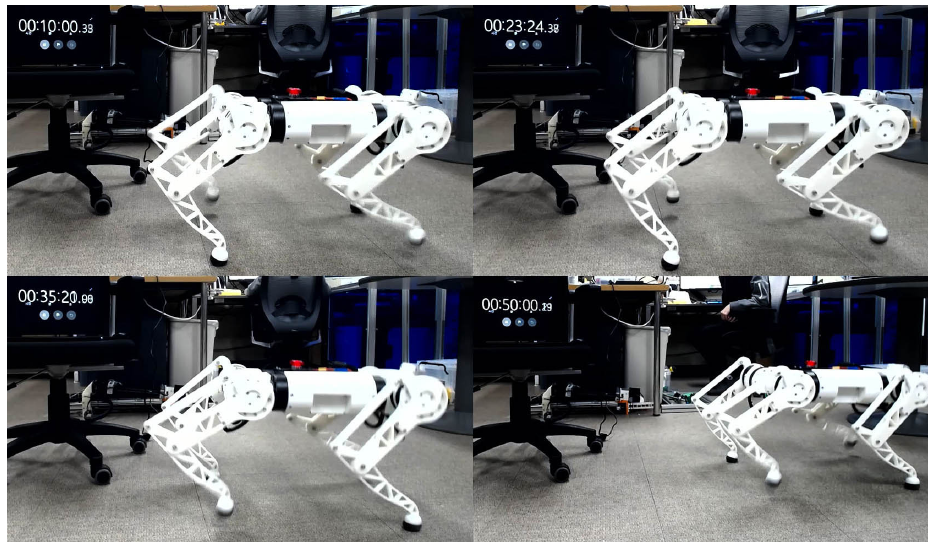
Figure 16. Continuous walking